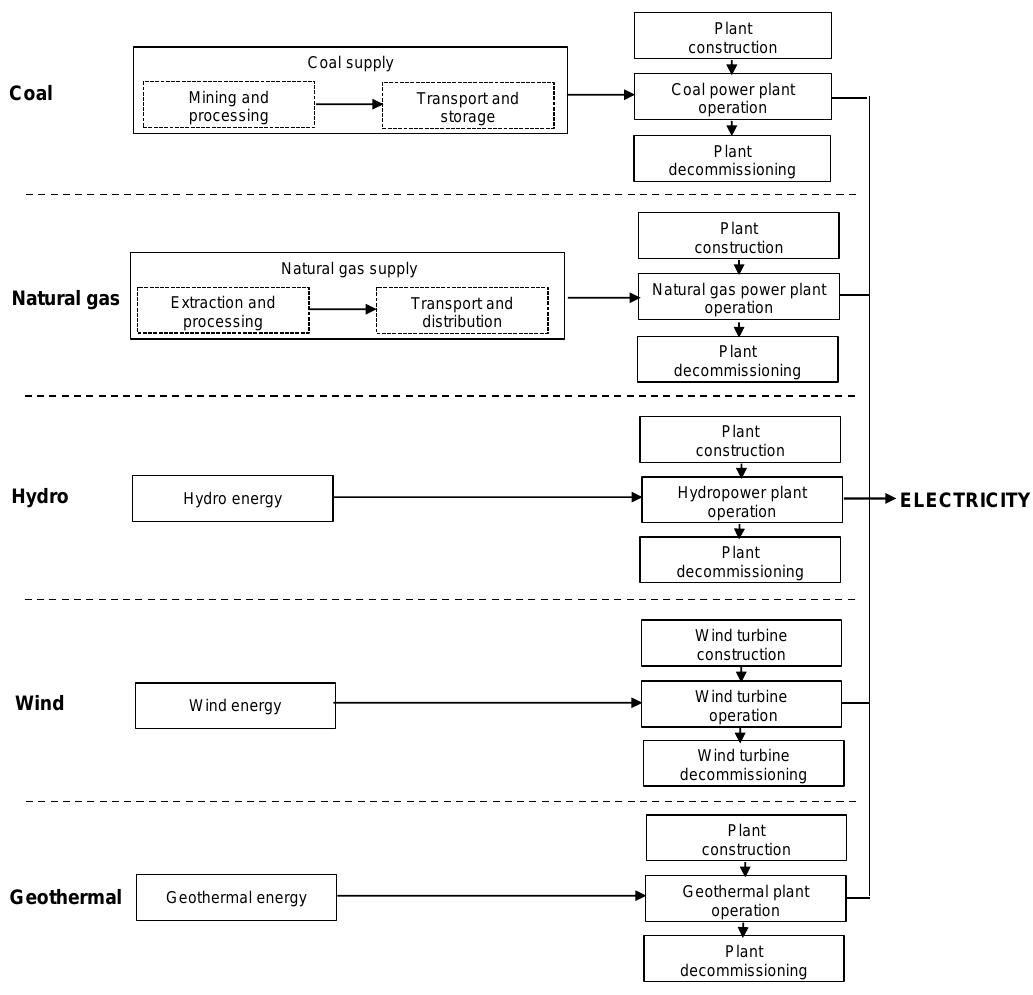
Figure 2. The life cycles of electricity from coal, natural gas, hydro, wind and geothermal power.